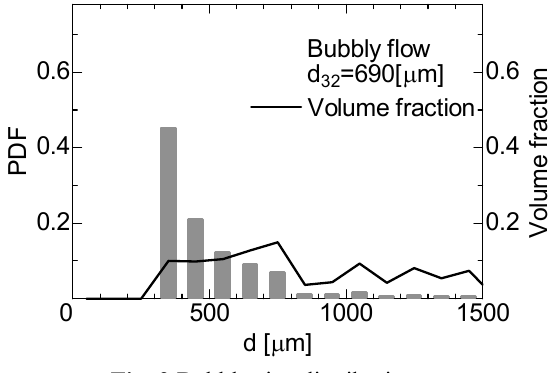
Fig. 2 Bubble size